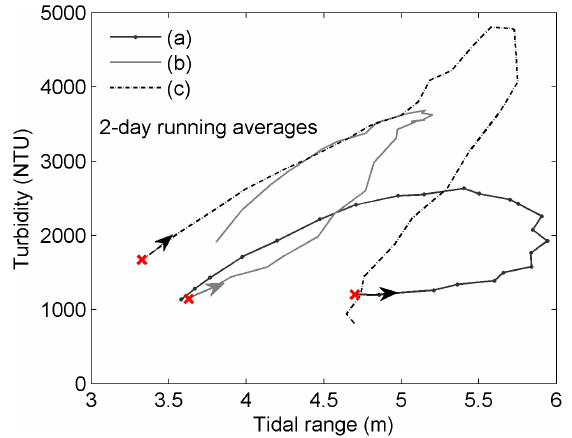
Figure 10. Turbidity as a function of tidal range (2-day running av- erages) for three neap–spring–neap cycles (see the cycles in Fig. 3d) during a period of (a) installation, (b) presence and (c) expulsion of the TMZ at Bordeaux.